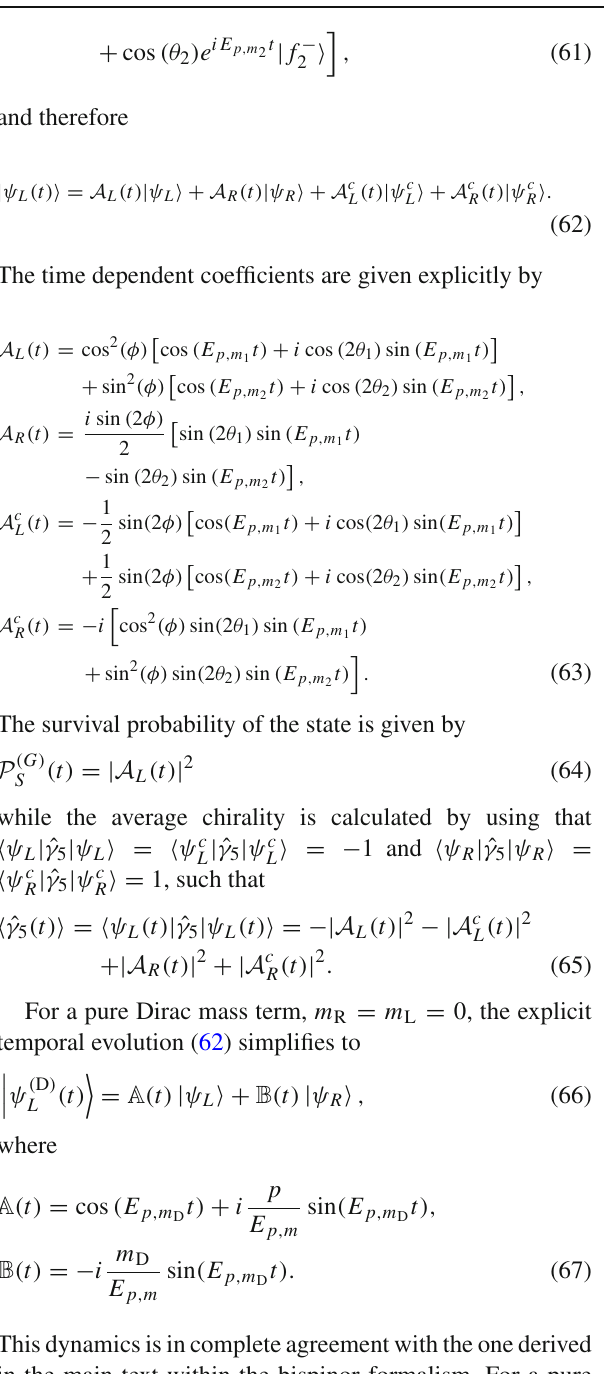
( t ) | ˆ γ (cid:5) ψ ( D ) L oscillations of the states